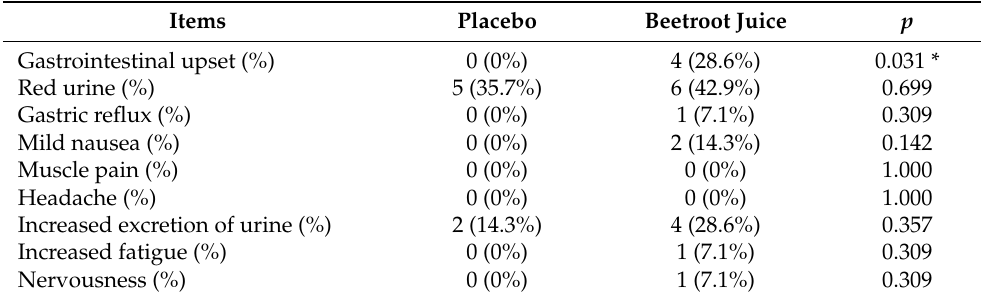
Table 1. Prevalence of side effects after the ingestion of 140 mL of beetroot juice or 140 mL placebo in semi-professional female rugby